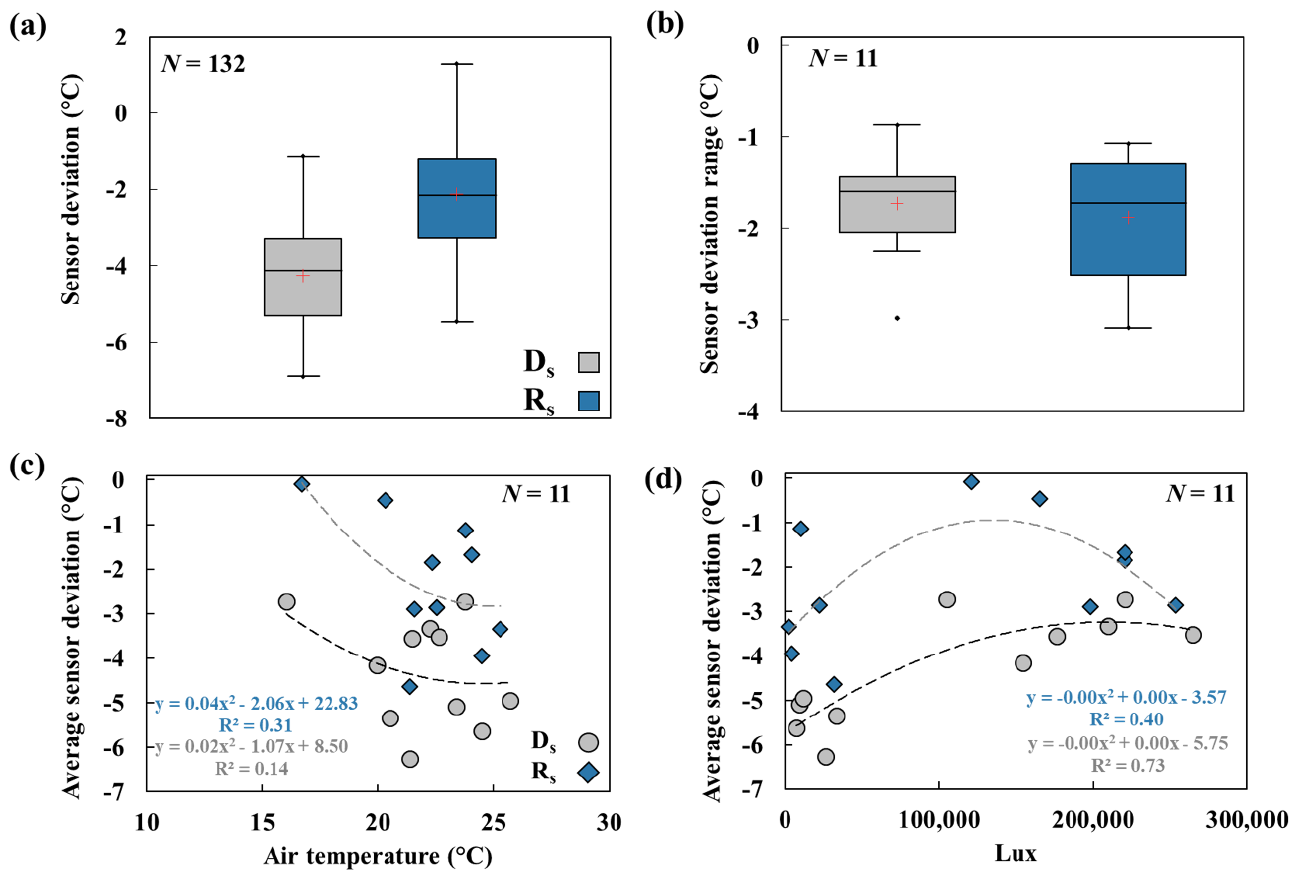
Figure 9. Sensor deviations for both sensors, with a lower deviation indicating higher accuracy ( a ). Range of deviations for both sensors ( b ), with deviation range an indicator of precision. Correlations between sensor deviation and air temperature ( c ) and sensor deviation and light ( d ).